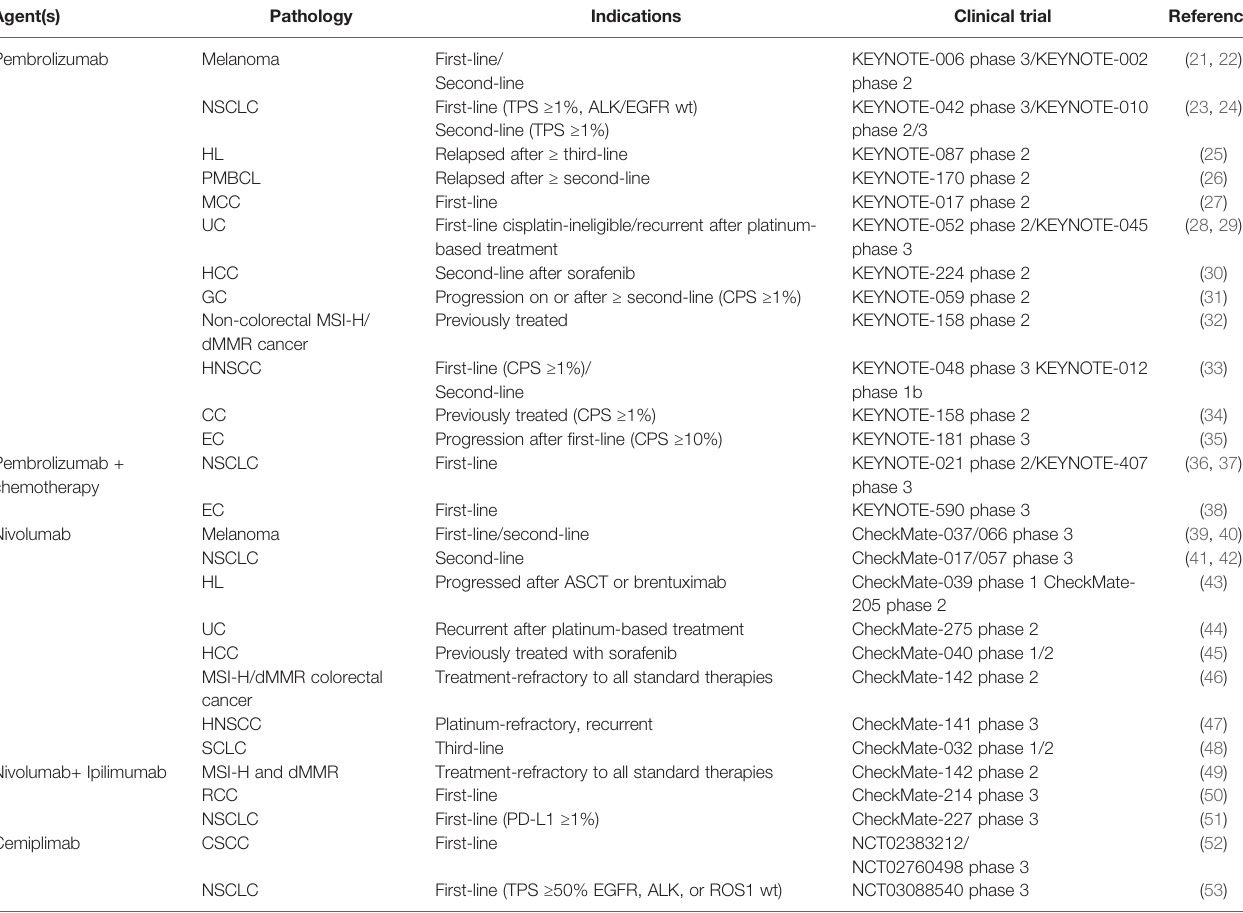
TABLE 1 | Summary of FDA-approved PD-1 inhibitors in advanced/metastatic cancers.